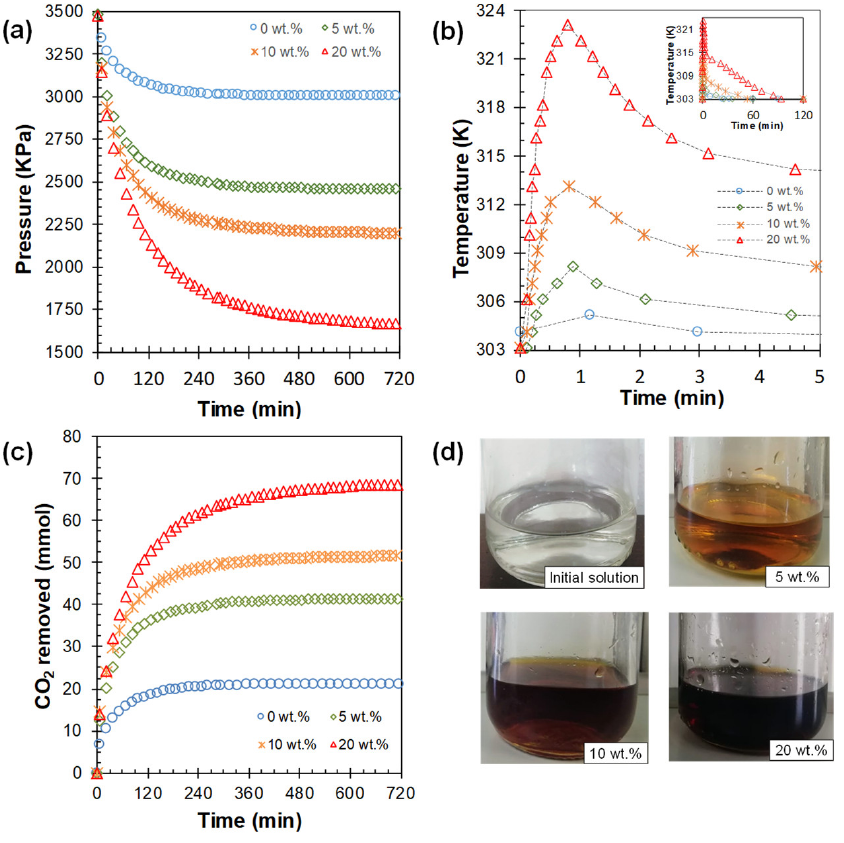
Figure 3. CO 2 capture using EDA: ( a ) pressure vs. time; ( b ) temperature vs. time; ( c ) CO 2 removed vs. time; ( d ) snapshots of aqueous amine solutions at the end of the experiments.